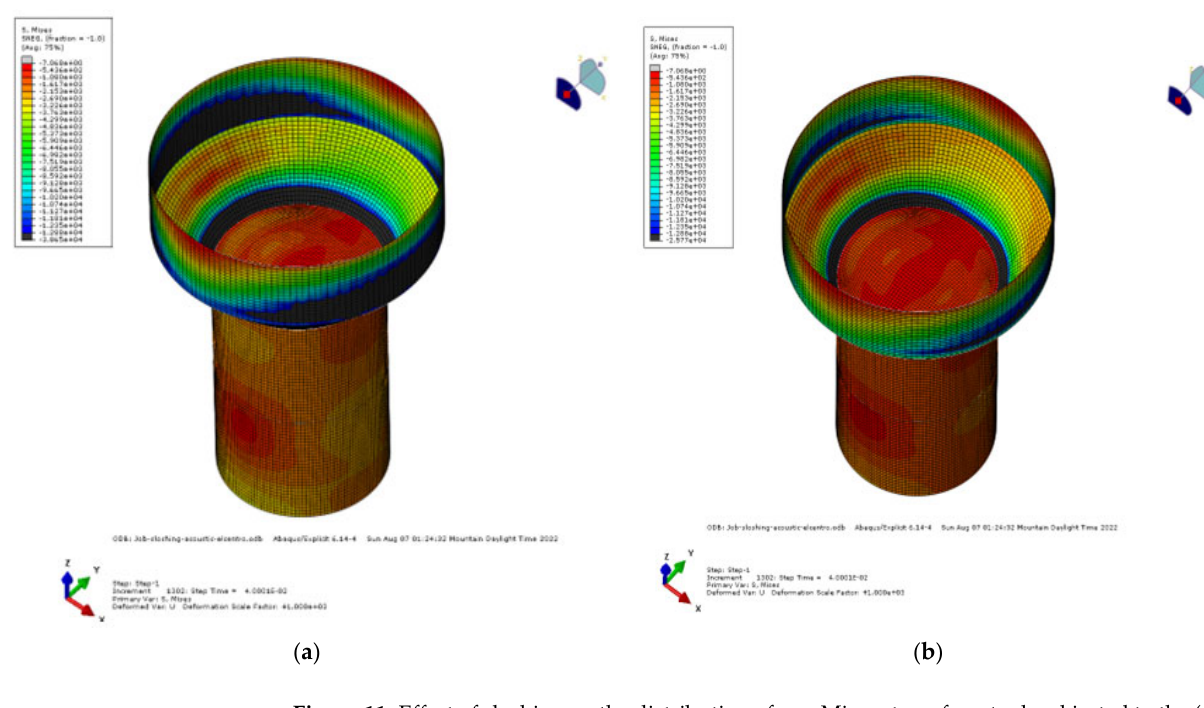
Figure 11. Effect of sloshing on the distribution of von Mises stress for a tank subjected to the ( a ) Kobe and ( b ) Northridge ground motions .